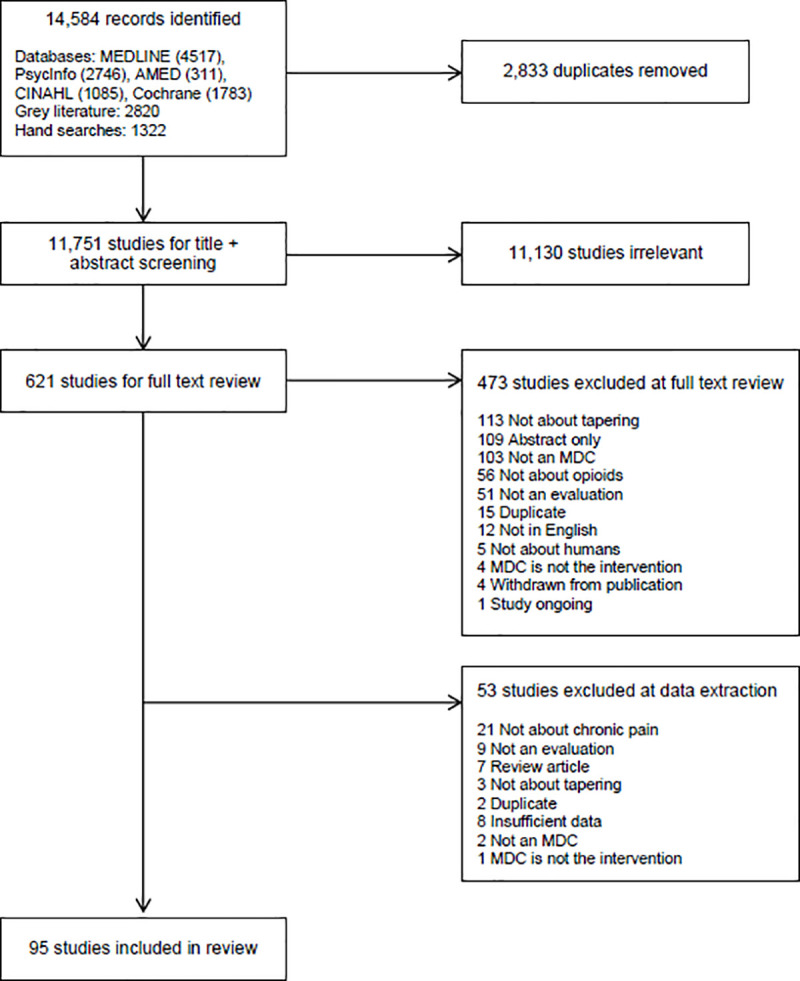
PRISMA flow diagram.